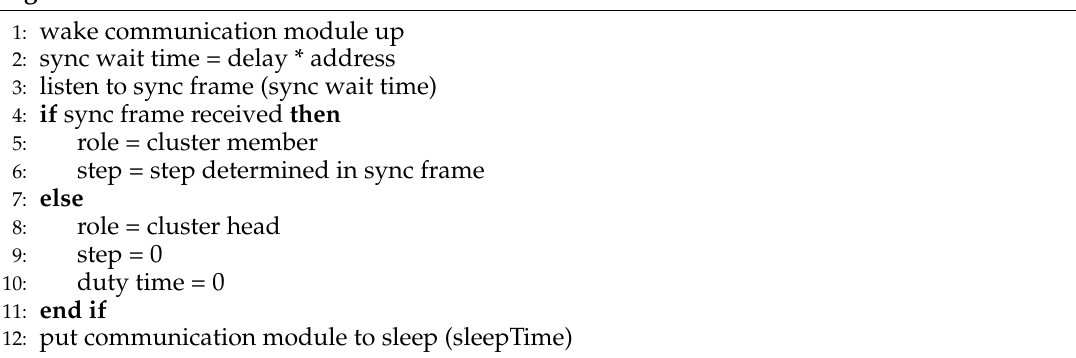
Algorithm 4 Initialization of sensor node